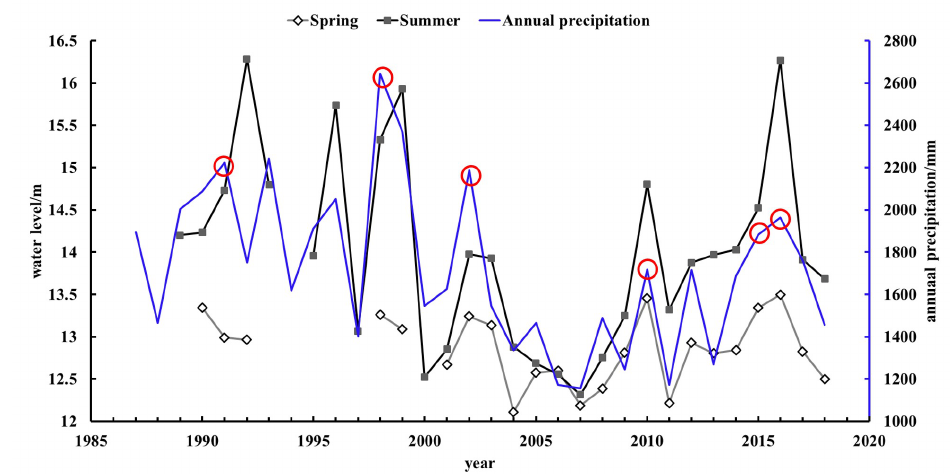
Figure 7. Annual precipitation, average spring water level and summer water level of Longgan Lake from 1987 to 2018. The red circles present years with abnormally high annual